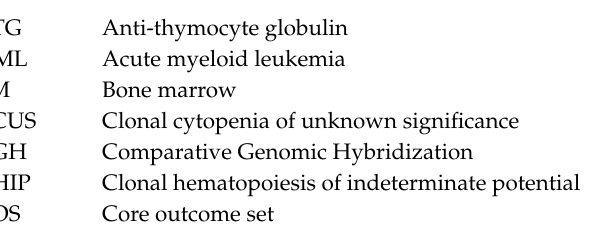
Table S1: Questions with insu ffi cient